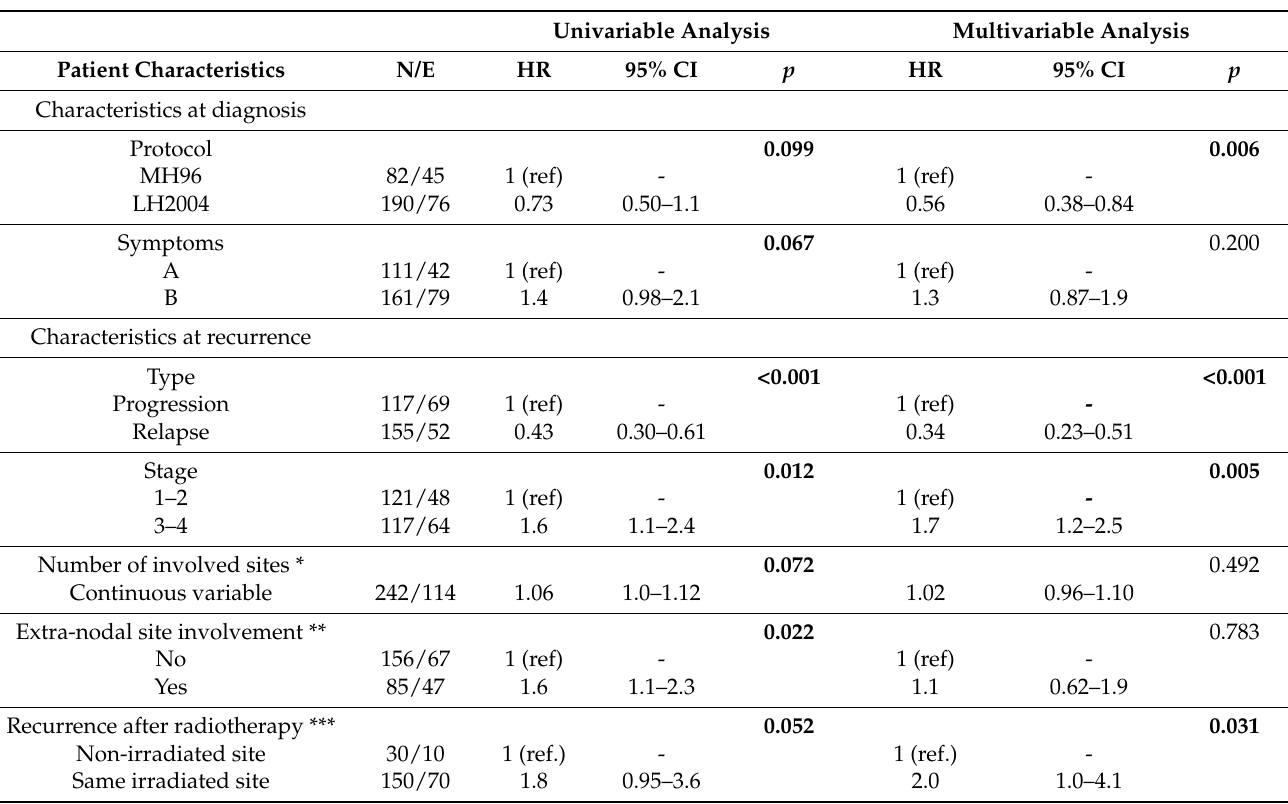
Table 9. Univariable and multivariable Cox regression model to assess the event-free survival after recurrence by characteristics at diagnosis and at relapse/progression of 272 patients with classical Hodgkin’s lymphoma.